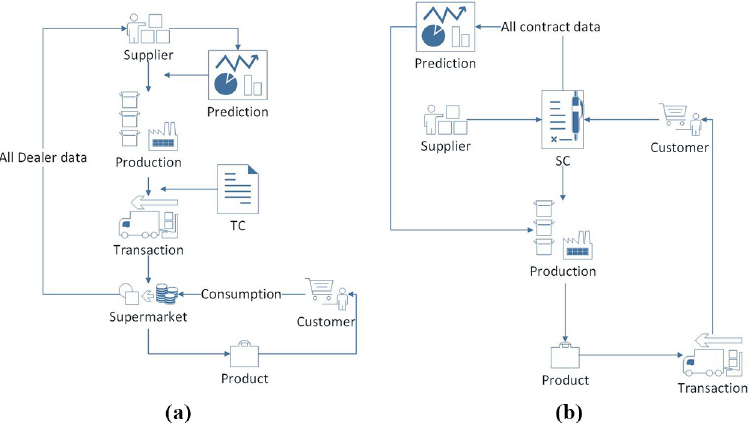
Figure 7. Transaction